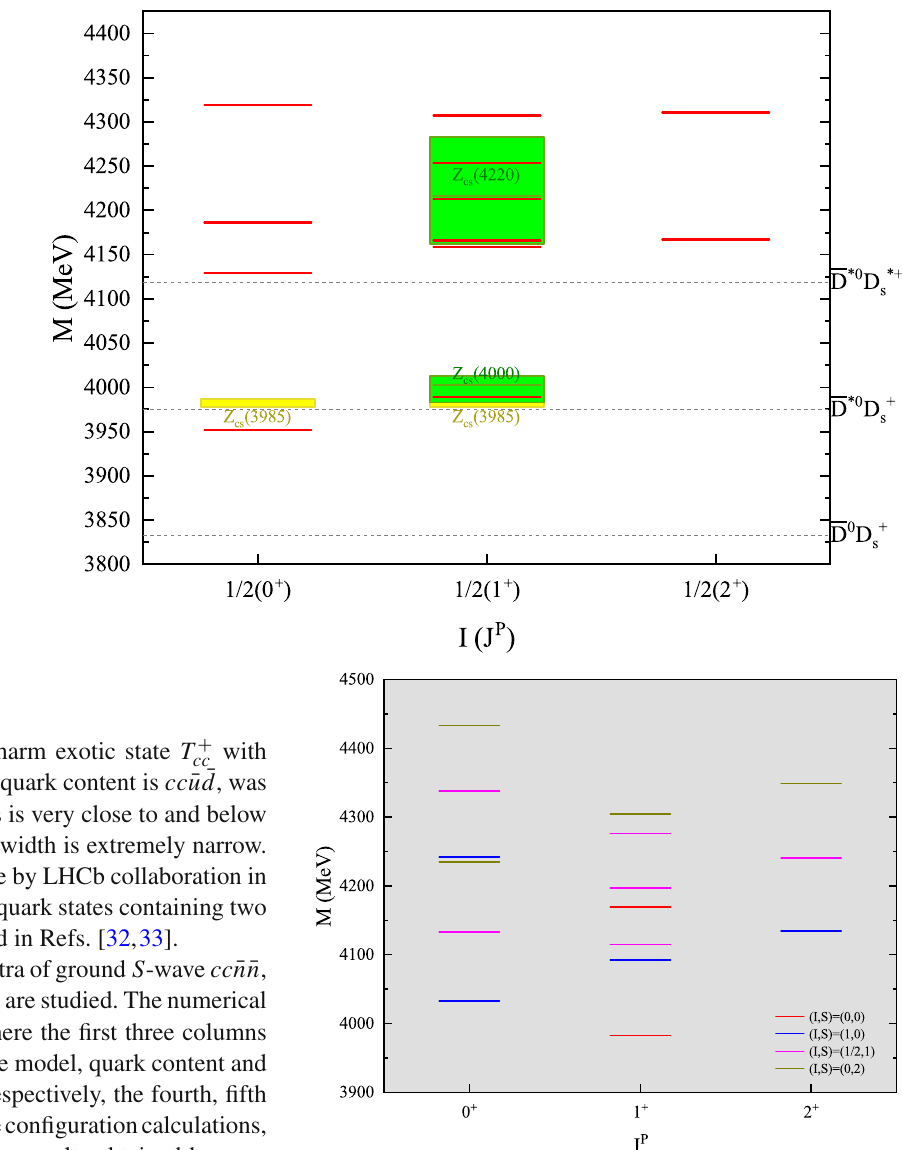
Fig. 4 The model spectrum of ground S -wave double-charm tetraquark states. Red solid lines denote T 0 , 0 cc states, blue solid lines denote T 1 , 0 cc states, pink solid lines denote T 1 denote T 0 , 2 cc